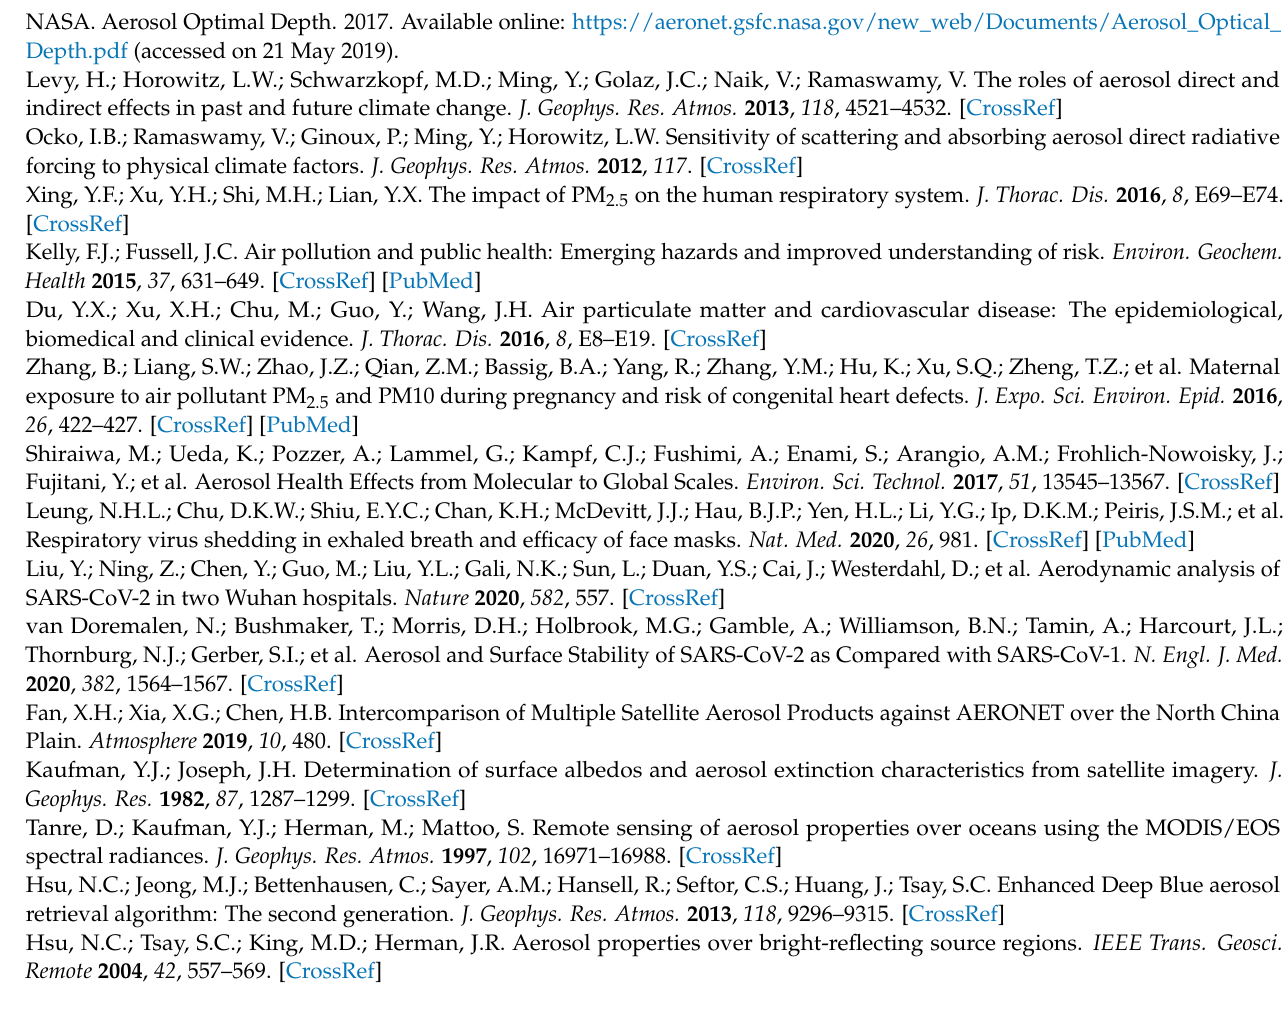
of daily PBLH for MAIAC AOD of mainland China, Figure S9: Time series of AOD mean (a) and standard deviation (b) in Beijing, Figure S10: Time series of AOD mean (a) and standard deviation (b) in Shanghai, Figure S11: Time series of AOD mean (a) and standard deviation (b) in Guangzhou, Figure S12: Time series of AOD mean (a) and standard deviation (b) in Chengdu, Figure S13: Spatial distributions of GAC for four seasonal days in Chengdu, Figure S14: Spatial distributions of GAC for four seasonal days in